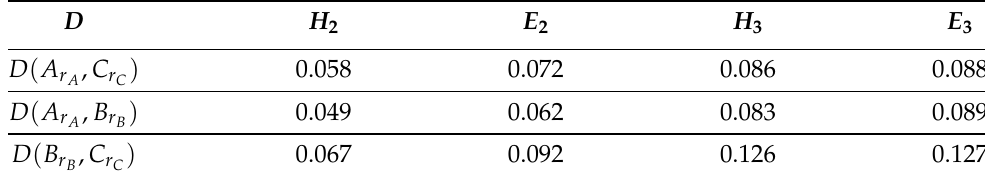
Table 4. Values of the distances H 2 , E 2 , H 3 , E 3